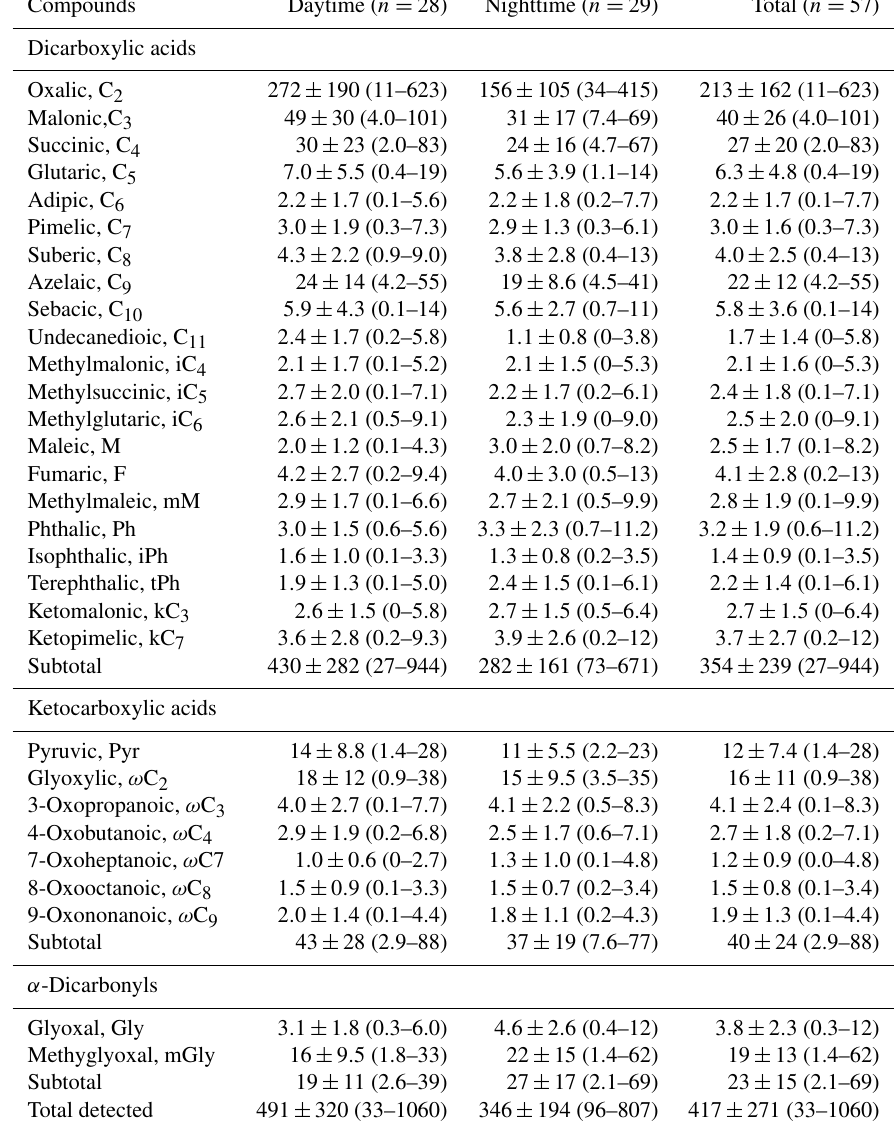
Table 2. Concentrations (ngm − 3 ) of dicarboxylic acids, ketocarboxylic acids and α -dicarbonyls of PM 2 . 5 from Mt. Tai in the